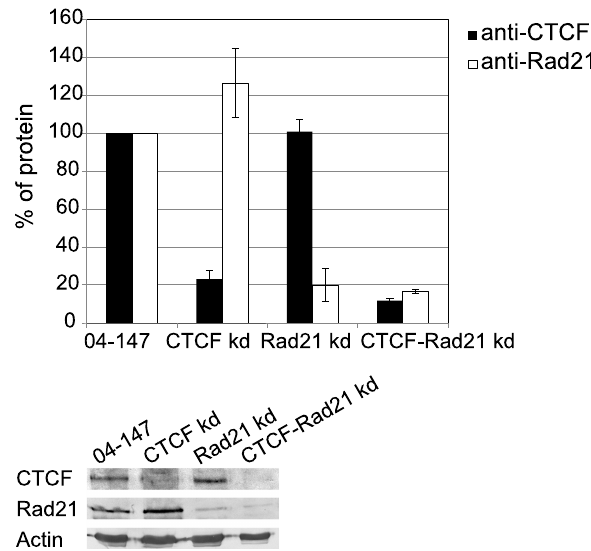
Figure 1. Knock-down of CTCF and Rad21. The nuclear fraction of control cells (04-147) and cells depleted of CTCF, Rad21 or both simultaneously were analysed by SDS-PAGE followed by immunoblot- ting. b -Actin was used as a control when calculating changes in CTCF and Rad21 protein levels after siRNA-mediated knock down. Average protein amounts of at least three independent experiments are shown. Error bars represent standard deviation.